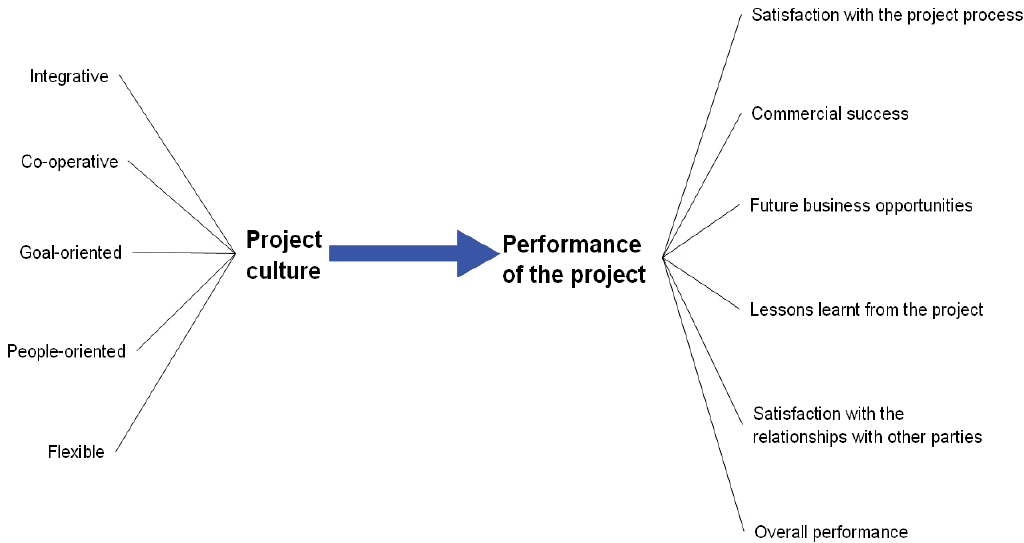
Figure 1: Research